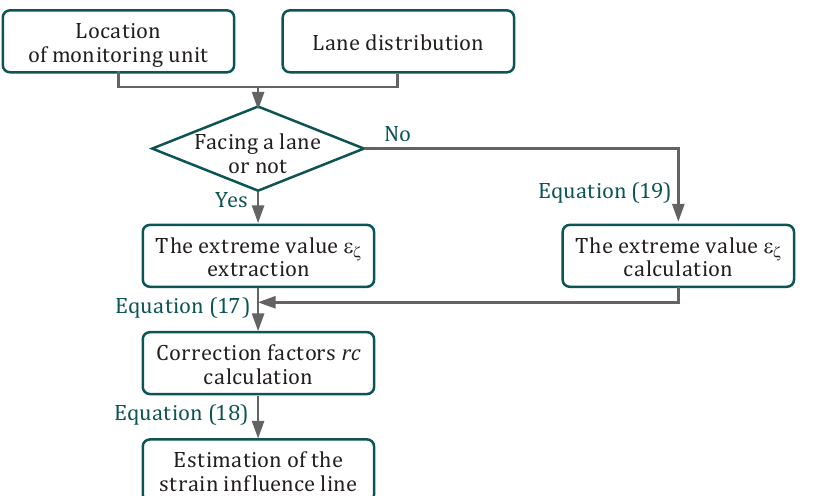
Figure 6. A flow chart of the proposed